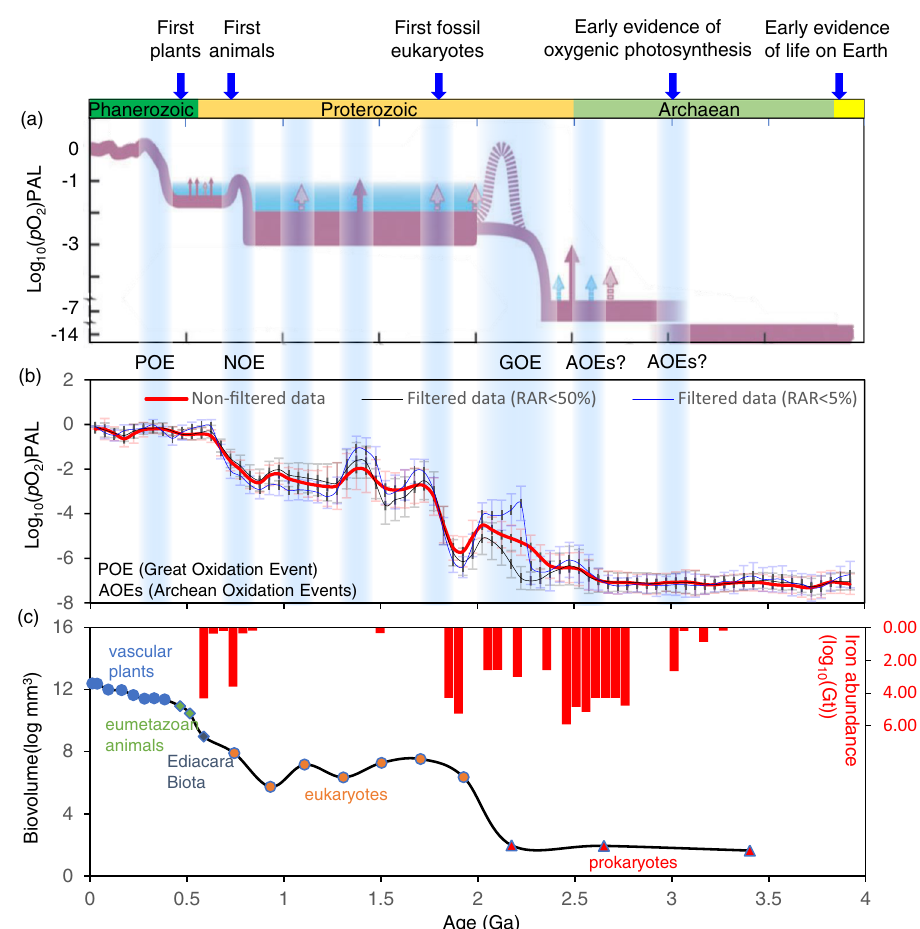
b Atmospheric O 2 levels across the last 4.0 Gyrs computationally recon- structed by machine learning using global ma fi c igneous geochem- ical data after been fi ltered using the relative age range 36 (RAR < 5% and 50%); error bars show 2-SD (standard deviation) uncertainties. c Temporal varia- tions in the maximum biovolume over the Earth ’ s history 62 , and iron forma- tion abundance 79